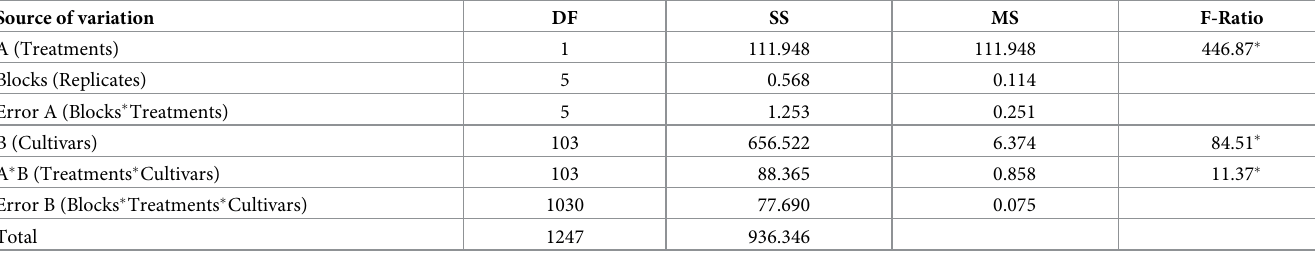
Table 5. Analysis of variance of cultivars and disease treatments for fiber contents. Source of